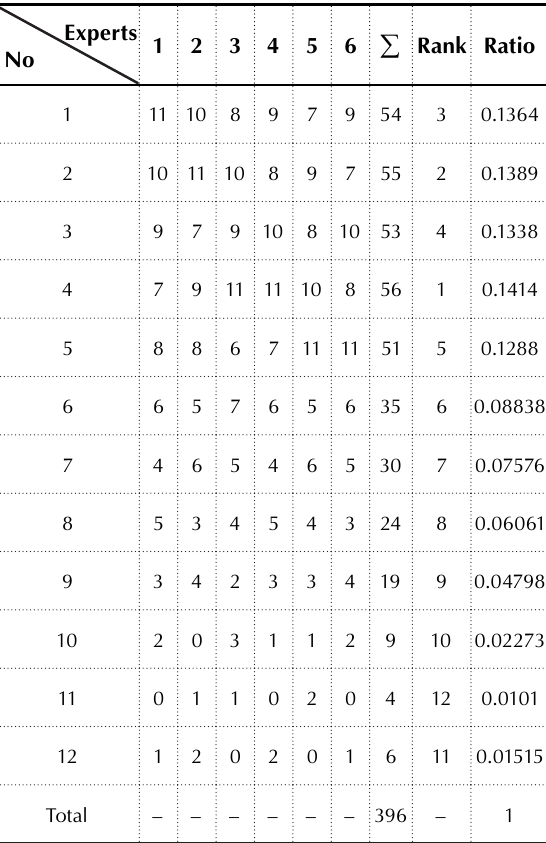
Table 8. Matrix of transformed ranks